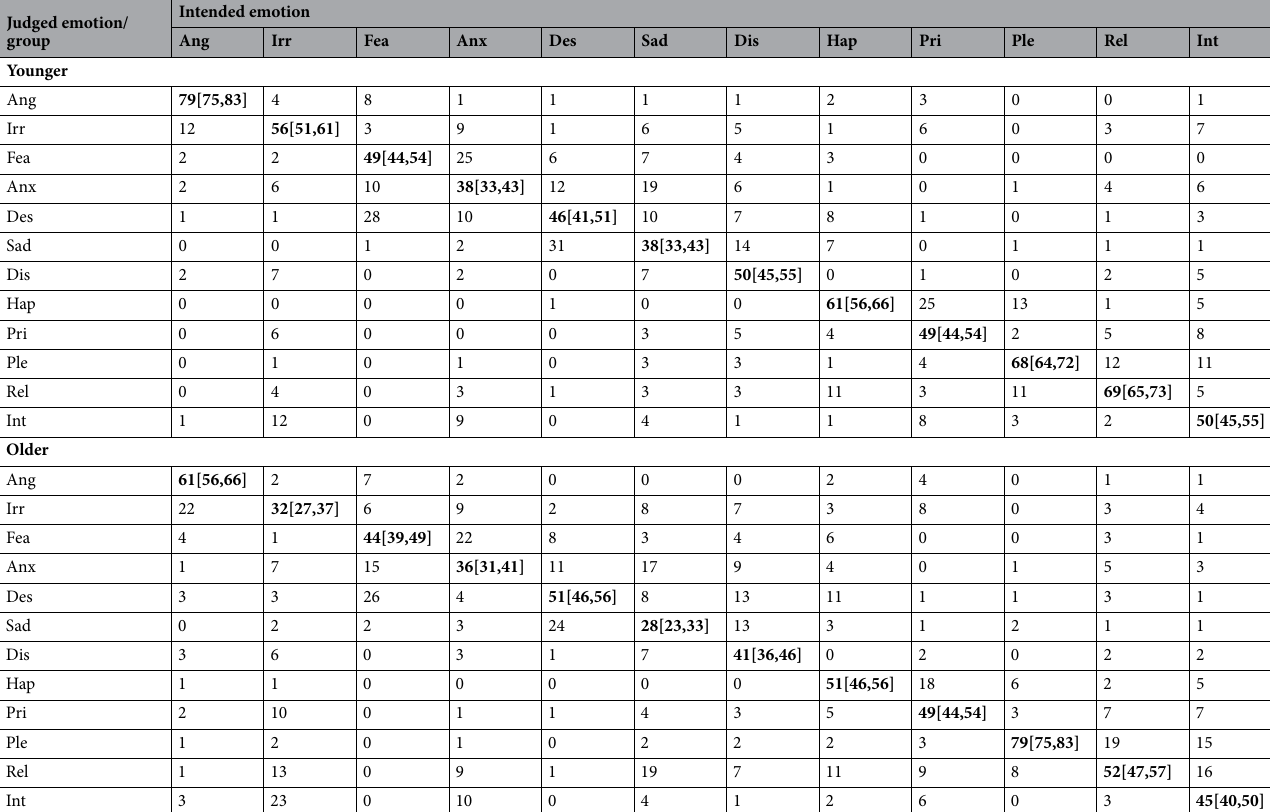
Table 1. Confusion matrix showing the proportion of judgments in Task 1 (the ERAM test) for each intended emotion and for both age groups. Diagonal cells represent the percentage of correct responses (marked in